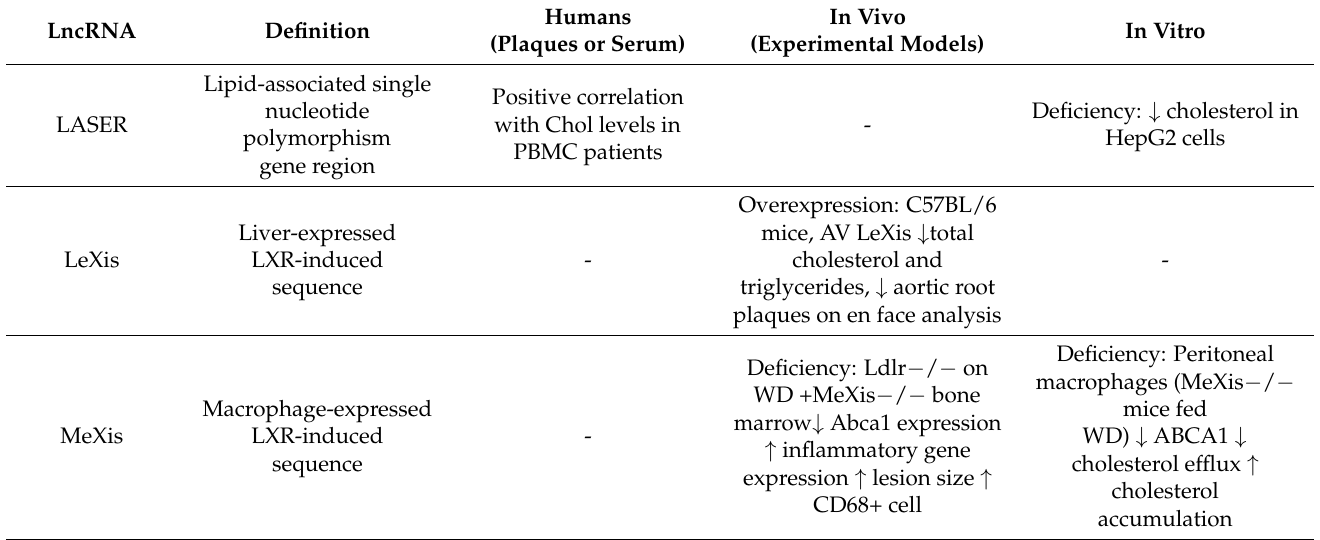
Table 1. List of lncRNAs implicated in